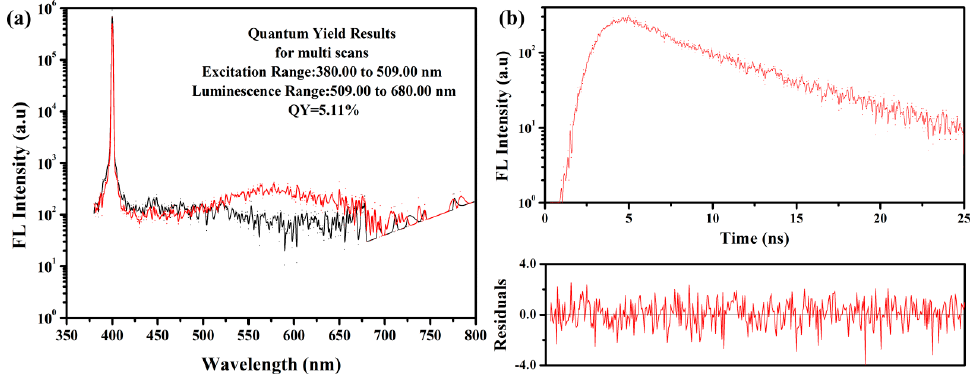
Figure 3. Fluorescence characteristics of N-CQDs. ( a ) Fluorescence quantum yield of N-CQDs; ( b ) fluorescence lifetime index fitting curve of N-CQDs.